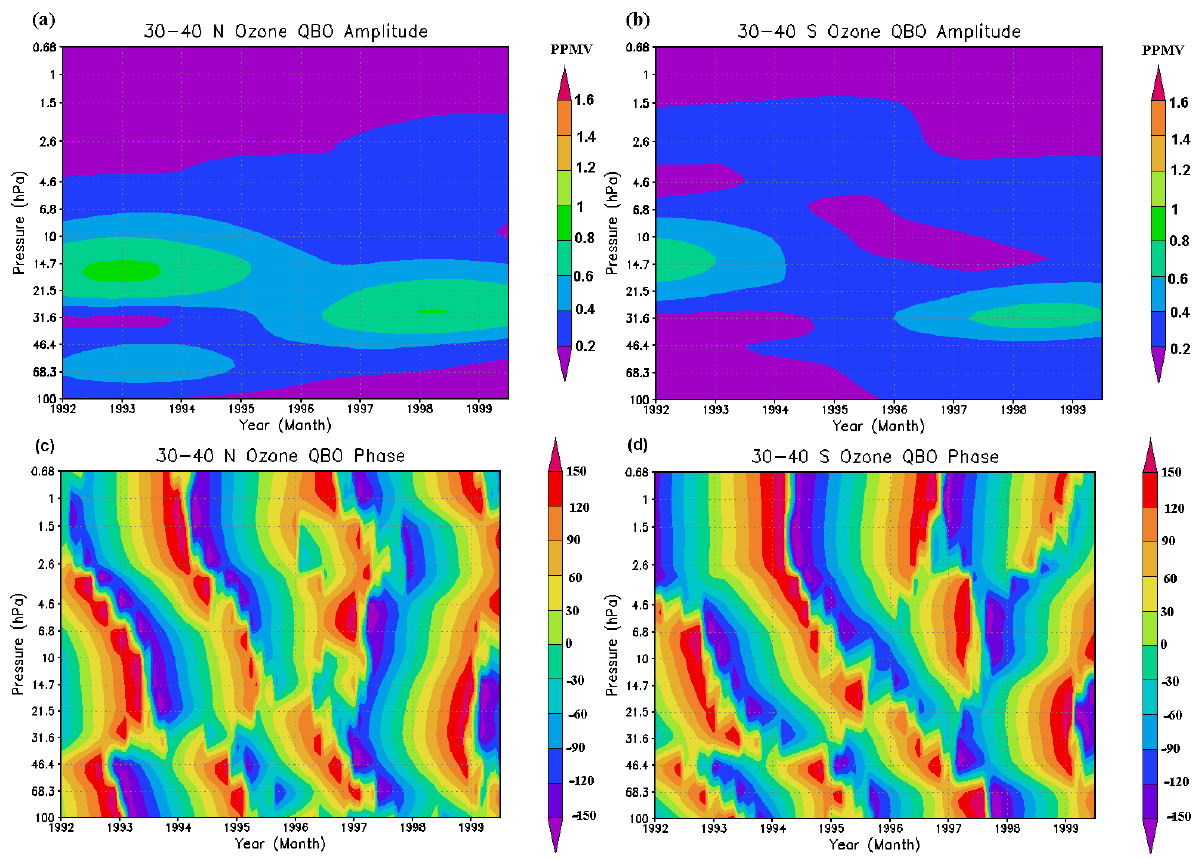
Fig. 6. Variation of amplitude of ozone QBO in time-height domain over (a) 30–40 ◦ N and (b) 30–40 ◦ S. Variation of phase of ozone QBO in time-height domain over (c) 30–40 ◦ N and (d) 30–40 ◦